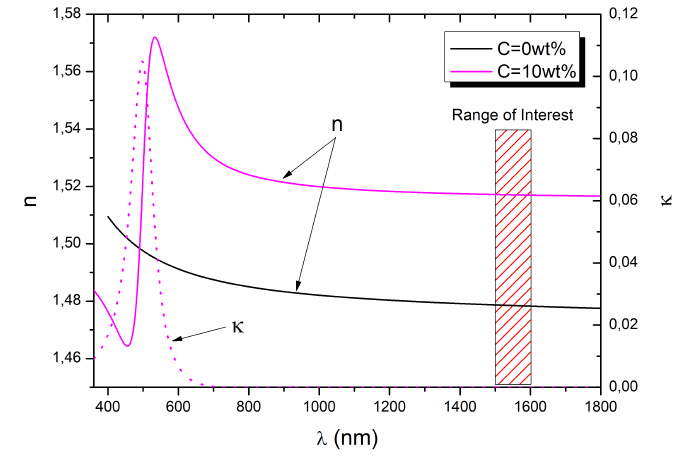
Figure 2. Dispersion curves of PMMA+DR1 for different mass concentrations C of the contained DR1 chromophore, where n is the refractive index and κ the extinction coefficient.